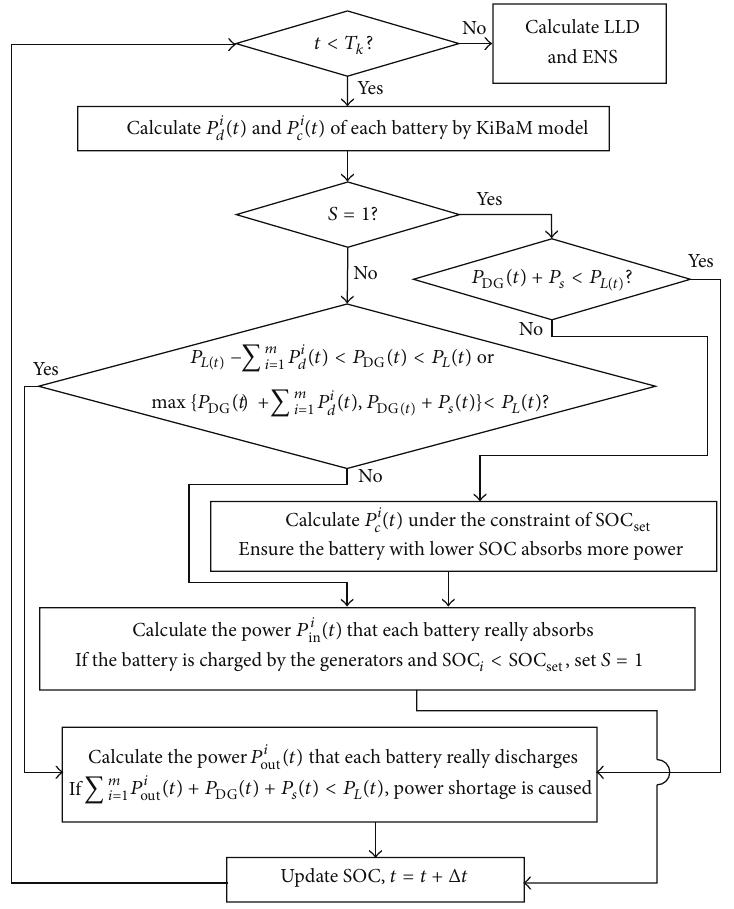
Figure 6: Simulation process in cycle charging